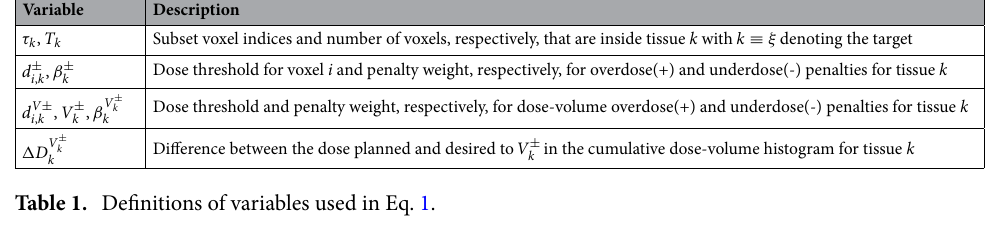
Table 1. Definitions of variables used in Eq.